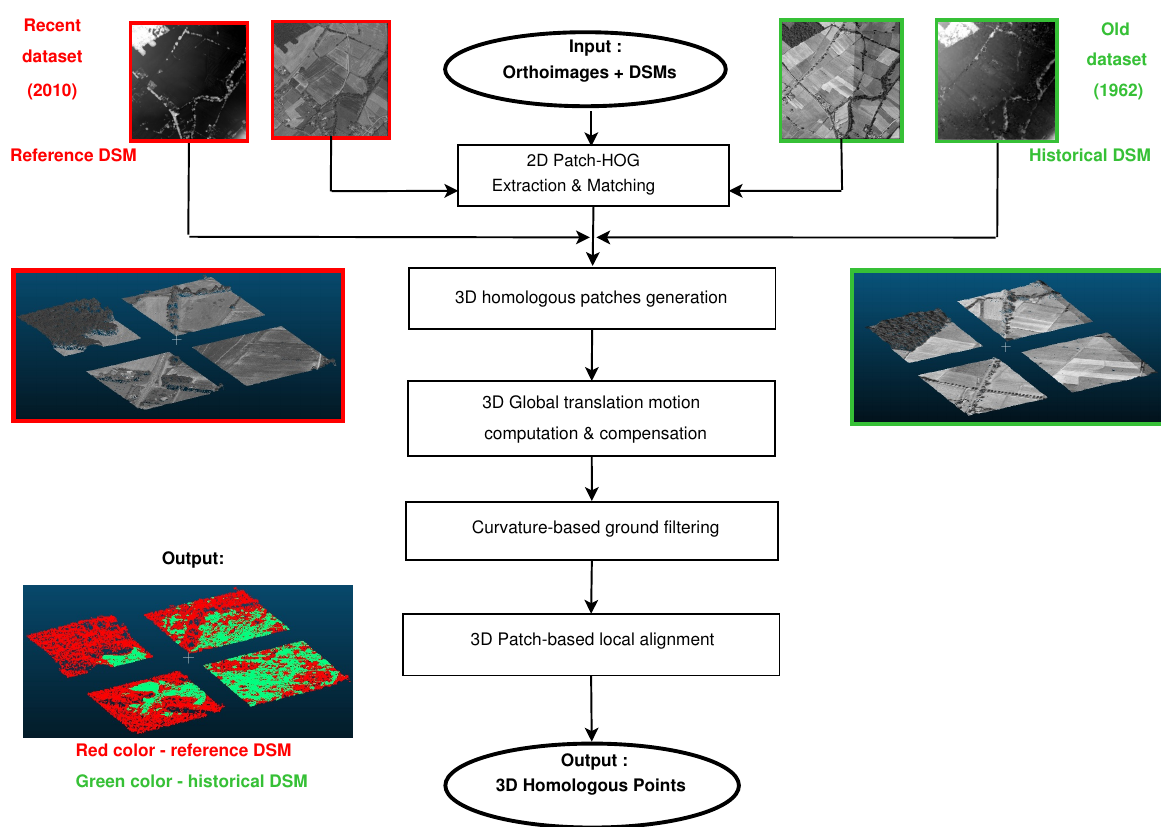
Figure 1. The workflow of the proposed automatic method for georeferencing archival aerial images acquired in unstructured environments. Example illustrated on the Fabas dataset (situated in France).